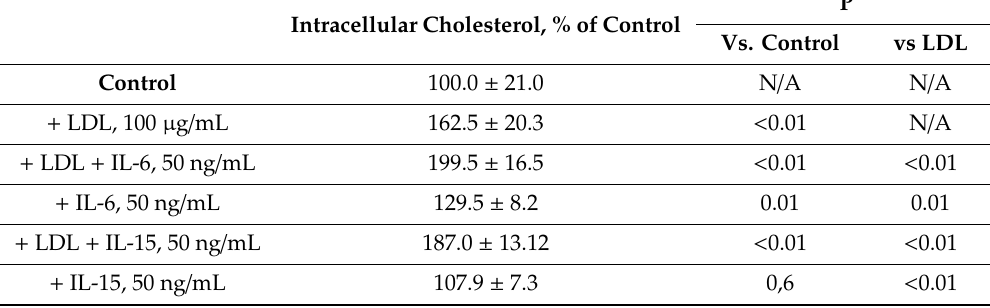
Table 2. E ff ects of inflammatory cytokines on intracellular cholesterol. Table 2. Effects of inflammatory cytokines on intracellular cholesterol.